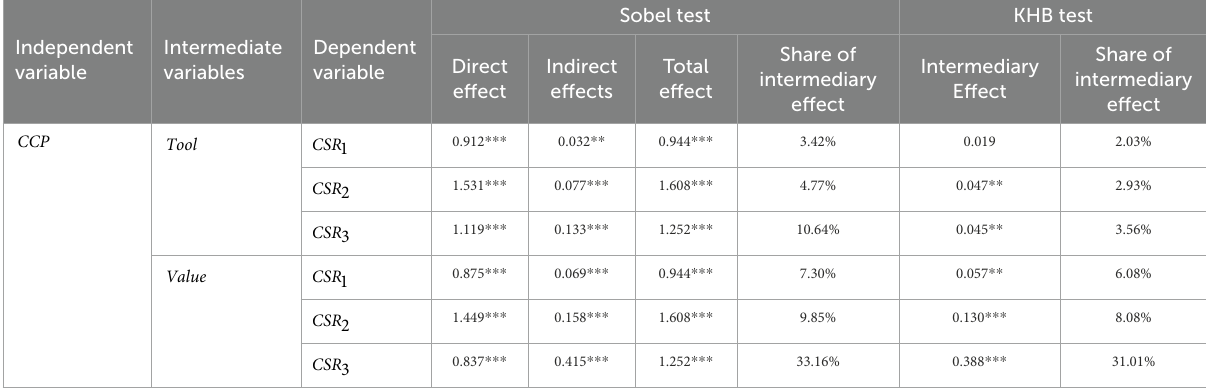
TABLE 5 Heterogeneity policy perceptions: the Sobel & KHB test.